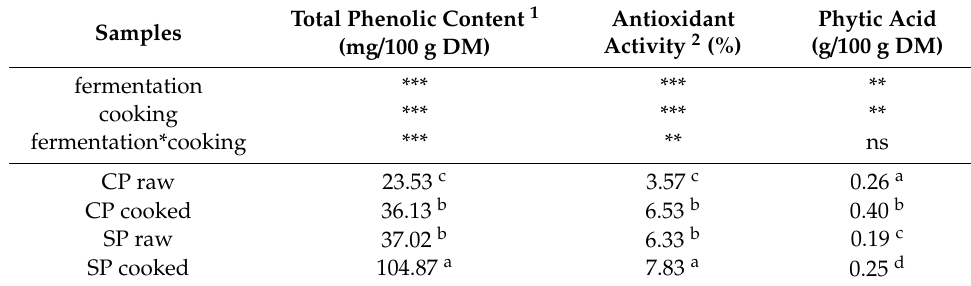
Table 4. Phytic acid and antioxidant activity in raw and cooked pasta. CP, control pasta and SP, pasta with